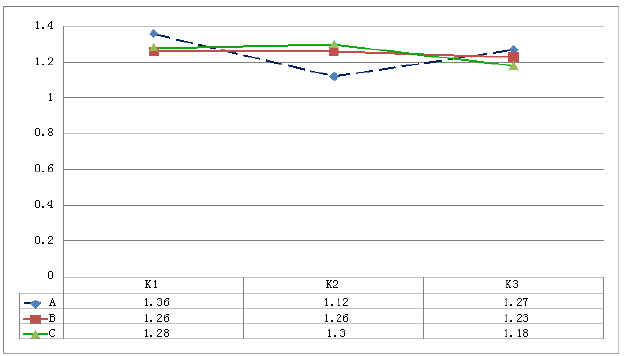
Figure 10: Relationship between factors, levels, and K values (steel fiber).